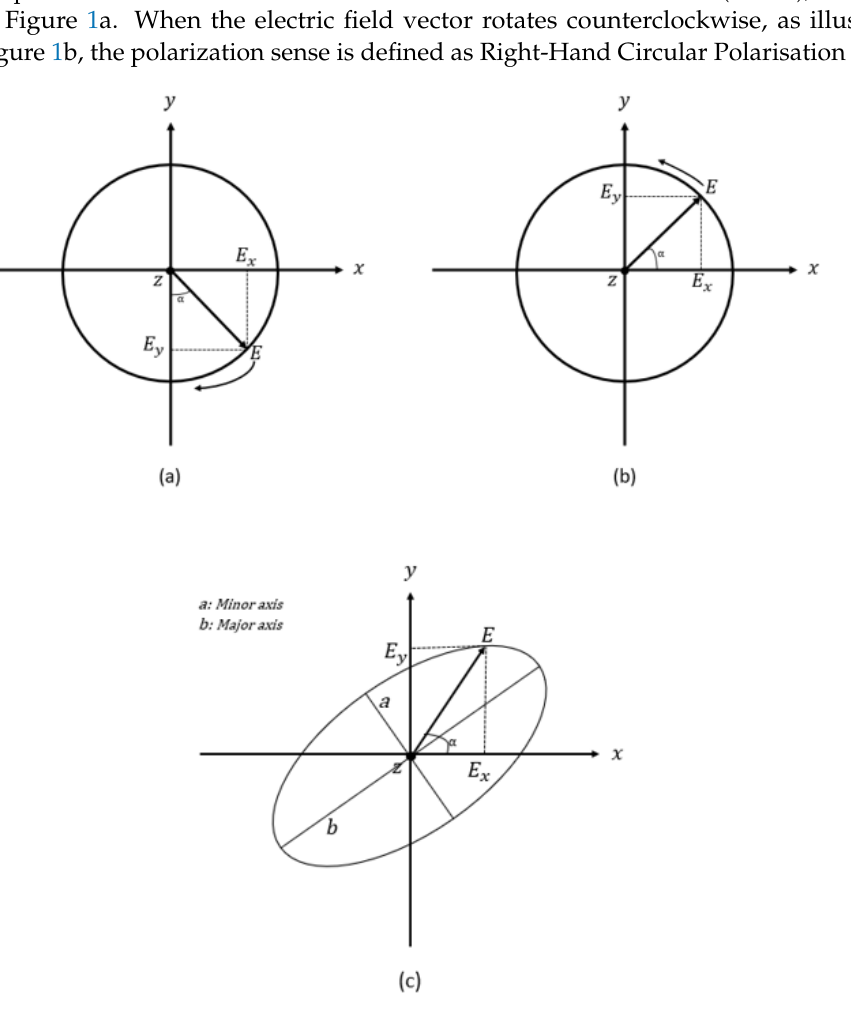
Figure 1. E-field vector of ( a ) Right-hand circular polarisation and ( b ) Left-hand circular polarisation ( c ) Elliptical